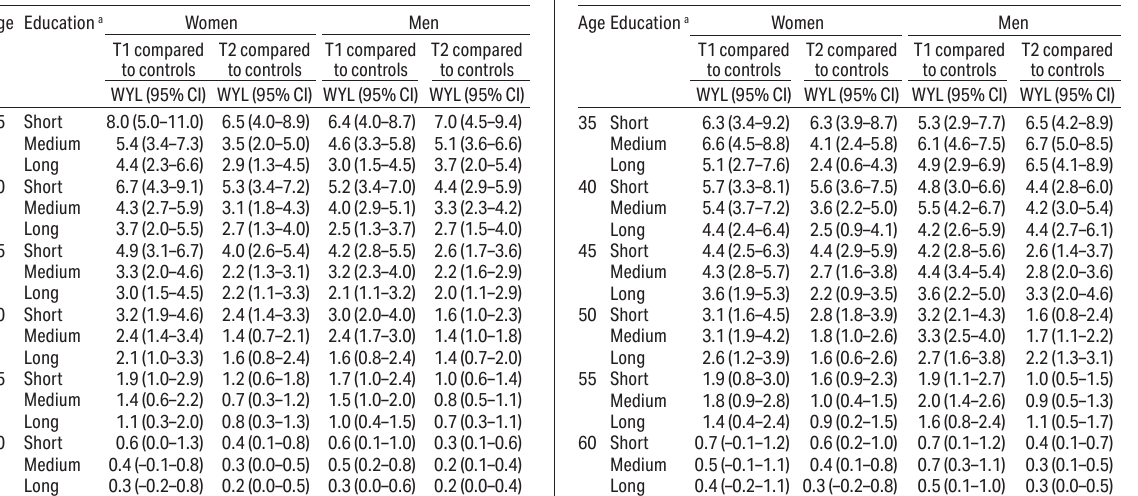
Table 3a. Working years lost (WYL) in years and 95% confidence inter - vals (CI) of cohabitant men and women with type 1 (T1) and type 2 (T2) diabetes compared to those without by age and education.